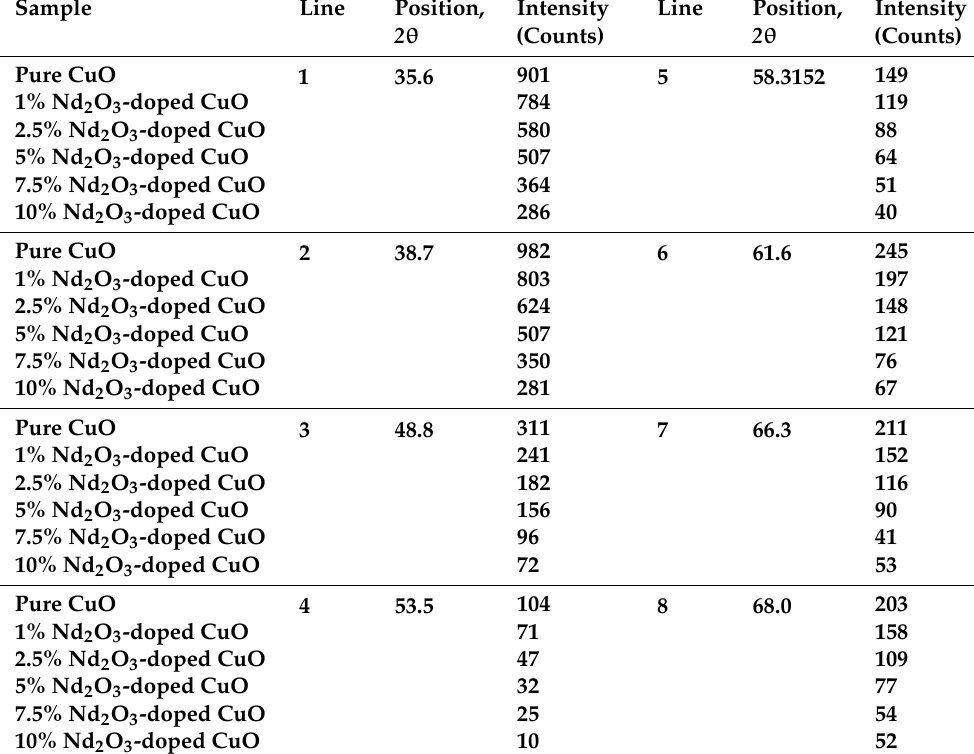
Figure 2. X-ray diffraction patterns for pure CuO and Nd 2 O 3 doped CuO nanostructured samples. Table 1. The values of diffraction peaks of the as-prepared NPs.